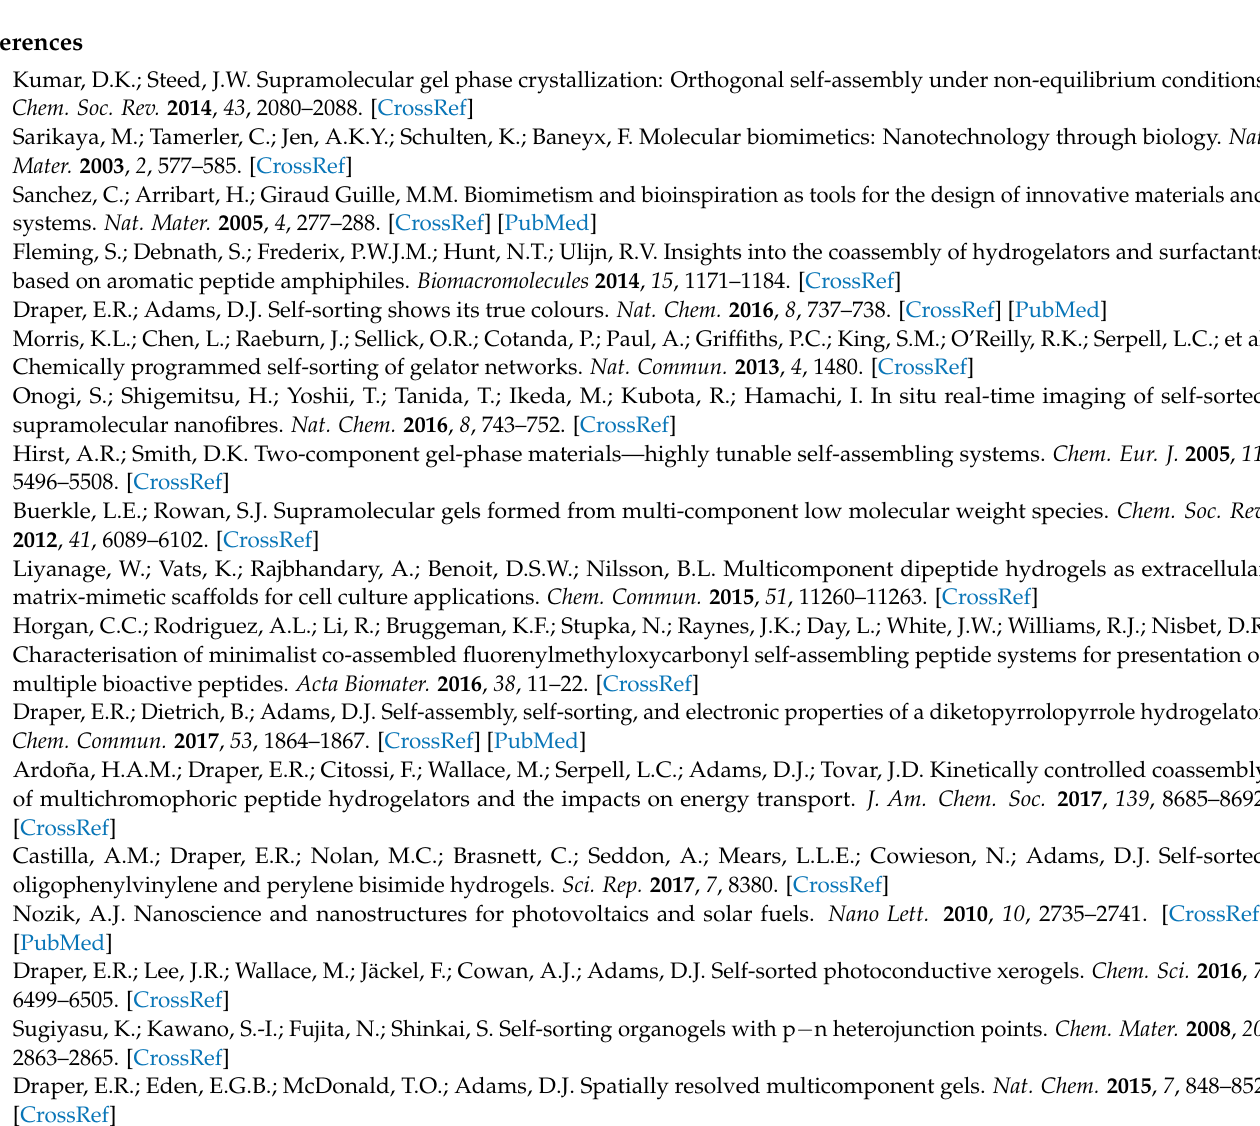
Figure S2: TEM images of single component hydrogels, Figure S3: TEM images of multicomponent hydrogels, Figure S4: CD spectra of FY and GMP solutions and corresponding hydrogels, Figure S5: FTIR spectra of FY and GMP powders and corresponding lyophilised hydrogel powders, Figure S6: TEM images of multicomponent hydrogels, Table S1: Tgel-sol temperatures recorded for single and multicomponent hydrogels. Details of the characterisation methods and analysis of the FTIR data as well as further data are available in the Supplementary Materials